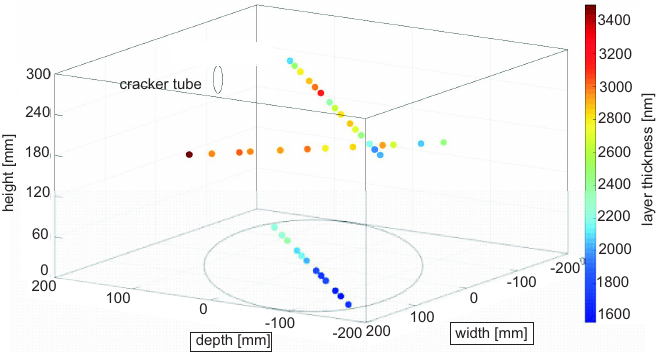
Figure 6. Layer thickness across the reactor. Each dot represents the averaged measurements across a microscope slide (length: 76